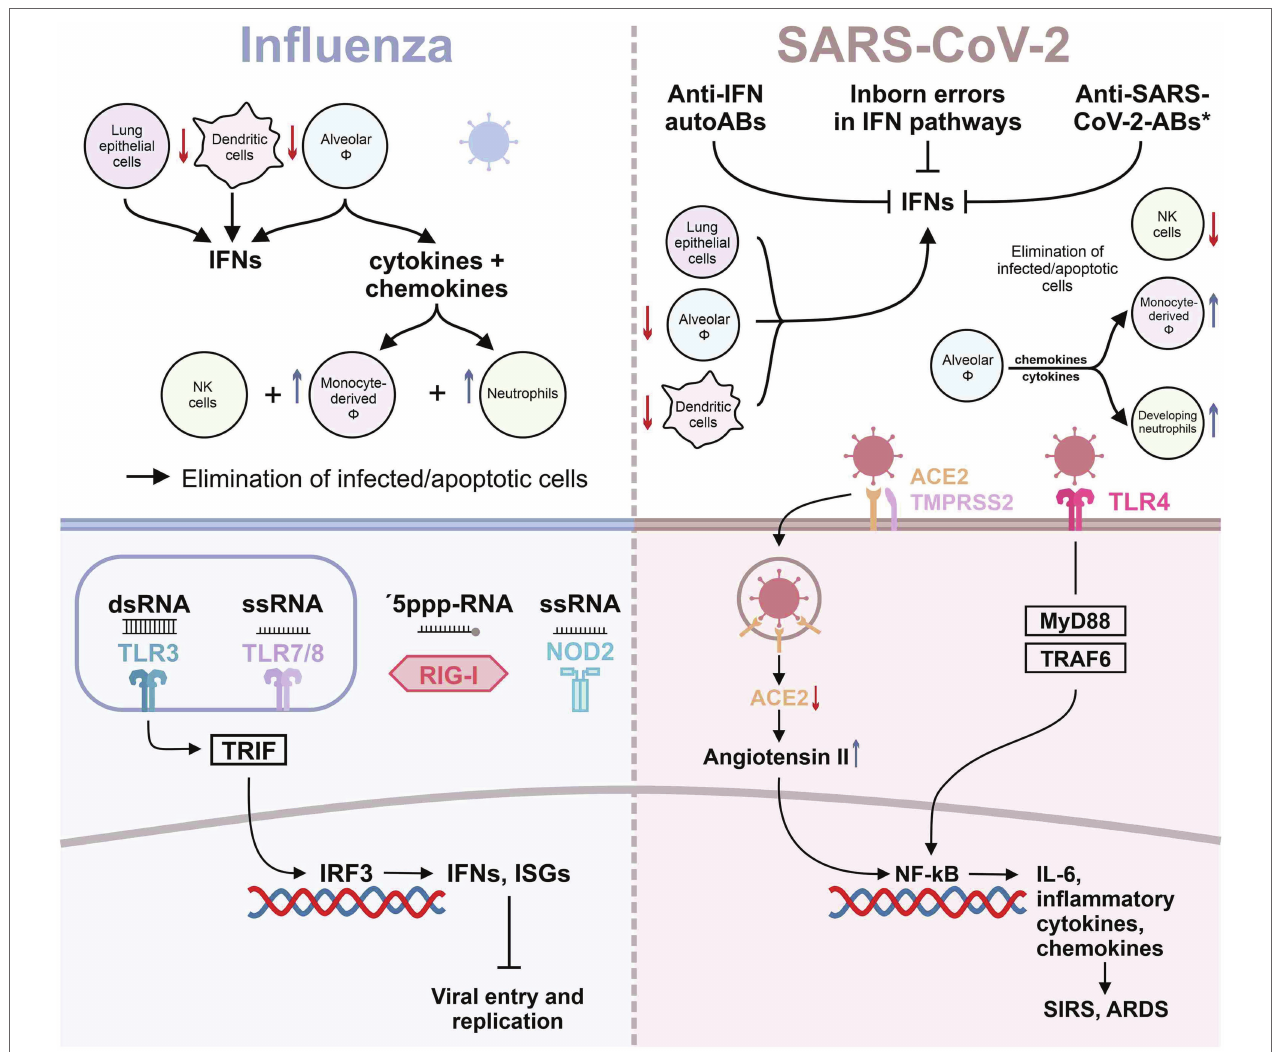
FIGURE 1 | Innate immunity in influenza and SARS-CoV-2 infection. The graph summarizes the current knowledge on innate immunity responses in influenza virus and in SARS-CoV-2 infection of the lung. *refers to anti-SARS-Cov-2 antibodies engaging with CD32B Fc receptors (Combes et al.,